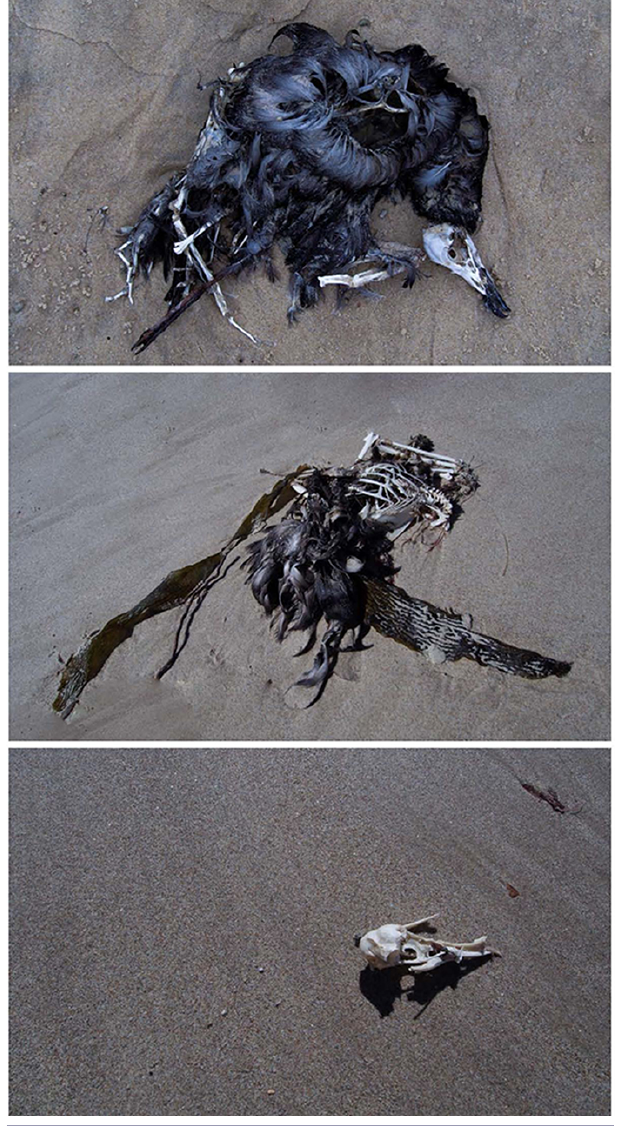
To provoke questions, the content of Figures 2 and 3 is similar to Figure 1. The production processes, however, enable larger, detailed compositions that more adequately and sensuously represent the delicate aesthetics, subtle colorings, and fragility of this species: the blue-black, glossy feather tips, the soft grey down, and the slender white bones. Applying a more minimal approach to montage, the photographs are arranged as a triptych to orientate viewers according to the temporal processes of burial (Fig. 2) and decay (Fig. 3) as the bodies (dis)integrate into the landscape. Importantly, the simple composition of bodies on washed sand leaves no clue as to the causal agents implicated in their deaths. The overall impact is one of beauty,